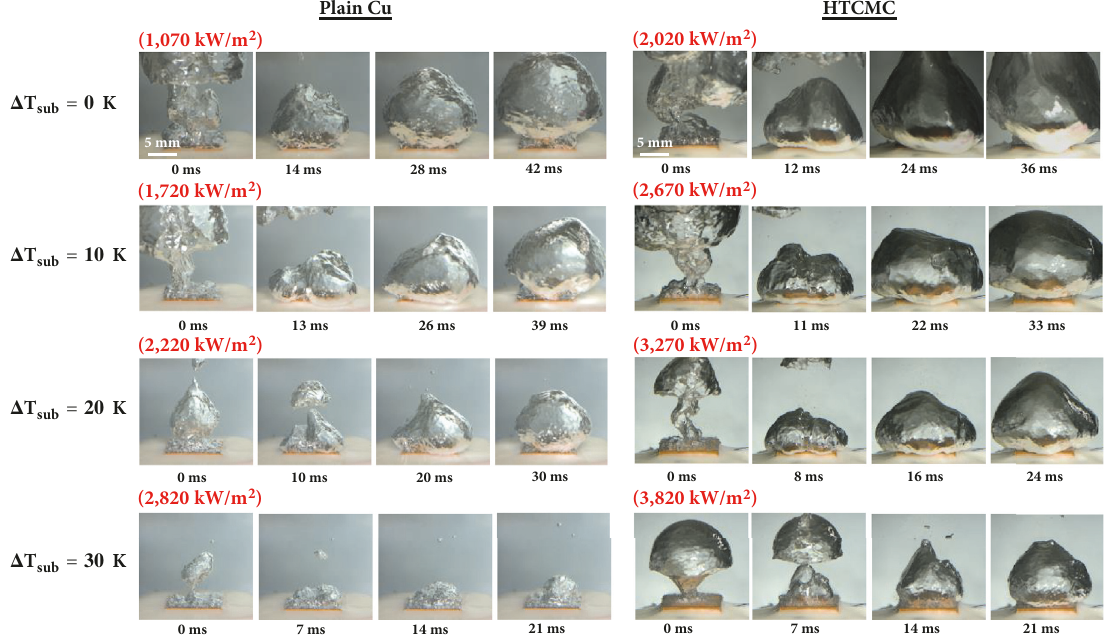
Figure 7: Nucleate boiling comparison of Plain Cu and HTCMC with different subcooled temperatures ( Δ T sub ) of 0K, 10K, 20 K, and 30K at the CHF. The values in parentheses represent applied heat fluxes.